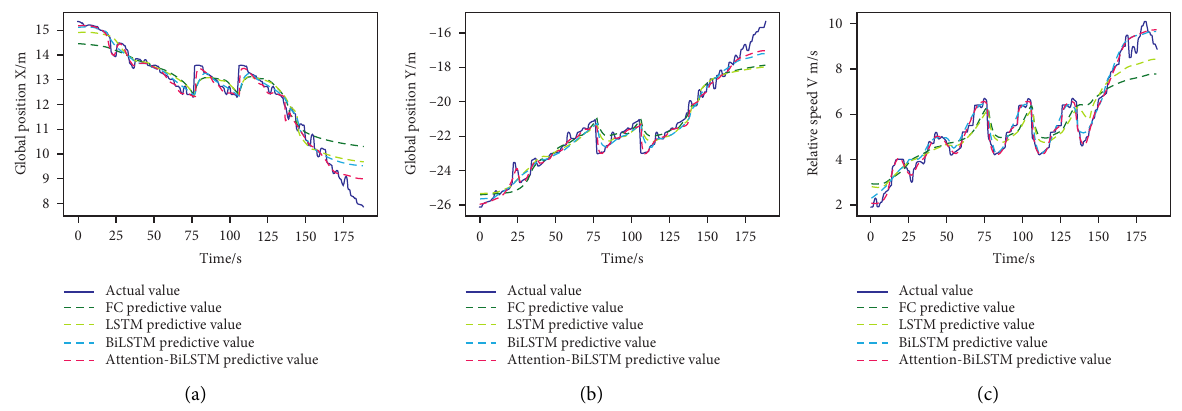
Figure 8: The prediction effects of different models on the same target vehicle state in the same scene.